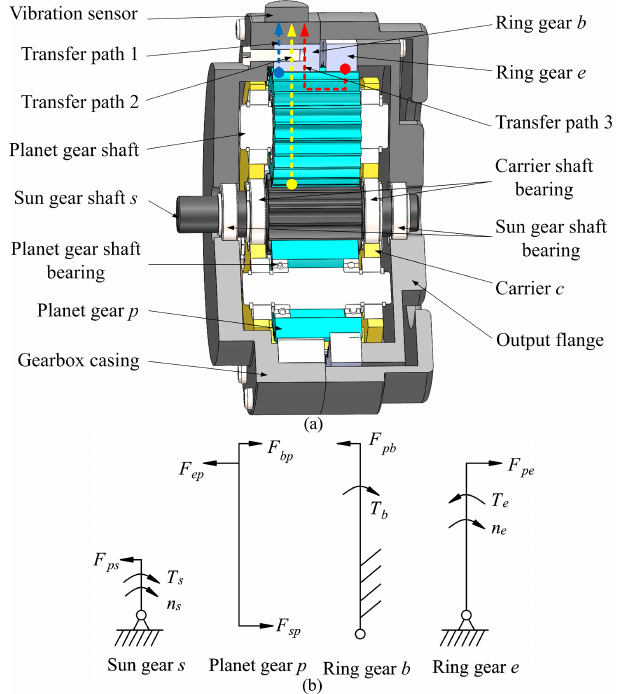
Figure 1. The 3K-II planetary gear set: (a) three-dimensional model; (b) Force analysis of each